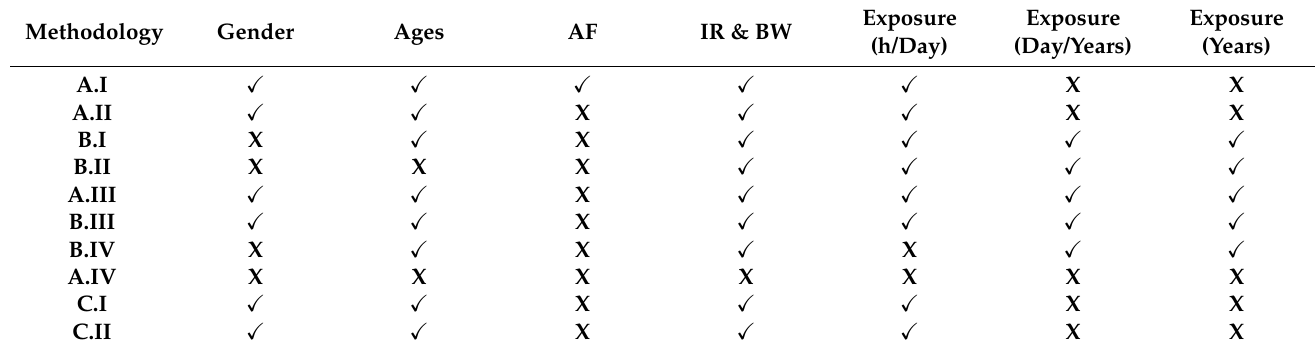
Table 8. Table of methodologies including